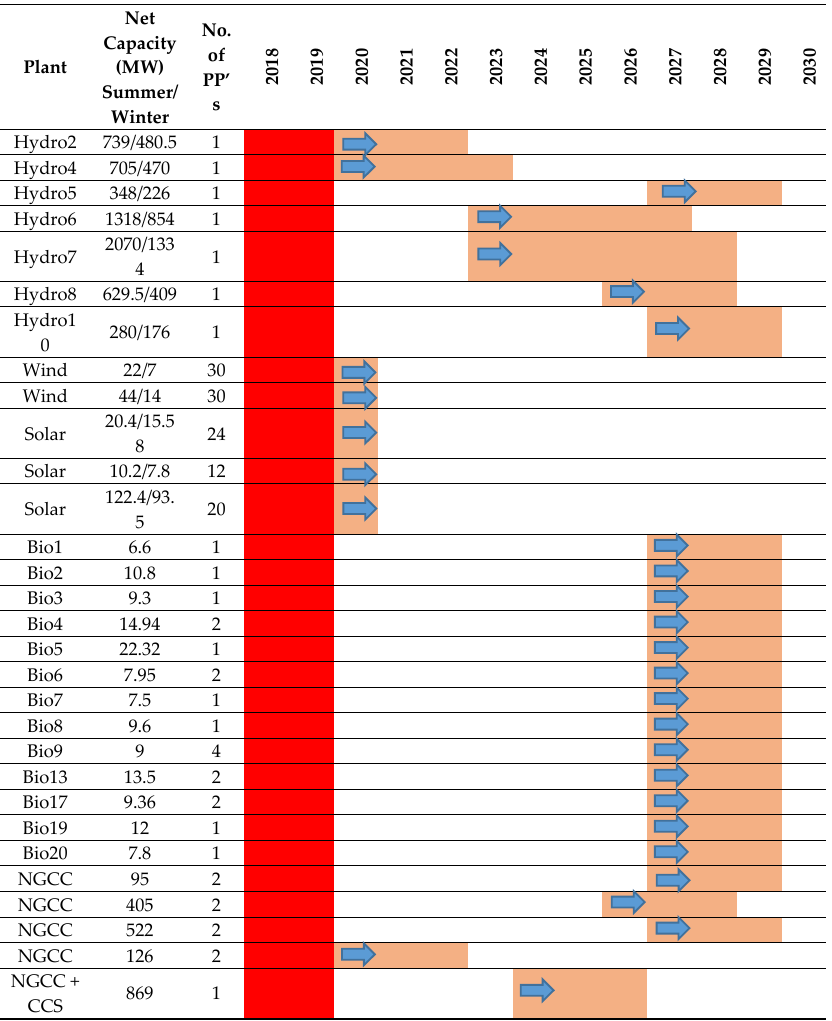
Table A9. Details of the Plants Installation under Capacity Expansion: Normal GDP Fuel Balancing (4–40% Mitigation).